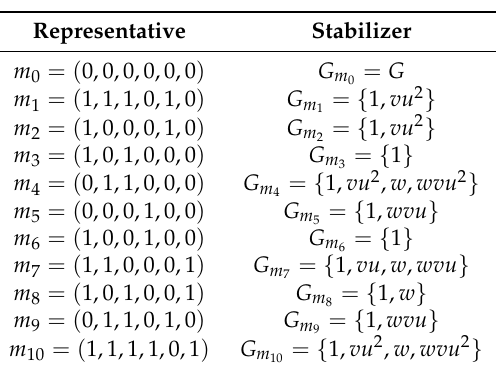
Table A8. Orbits representatives and